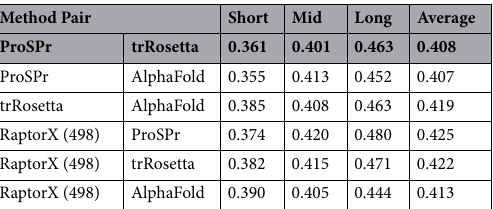
Table 2. Jaccard distances for pairs of deep learning distance prediction networks and the top performing CASP13 contact prediction group (RaptorX) for each contact